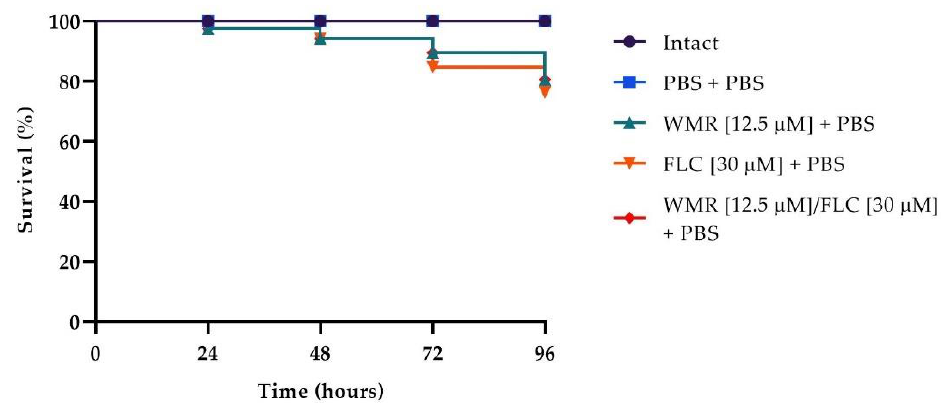
Figure 7. Toxicity of WMR and FLC and their combination on G. mellonella larvae.